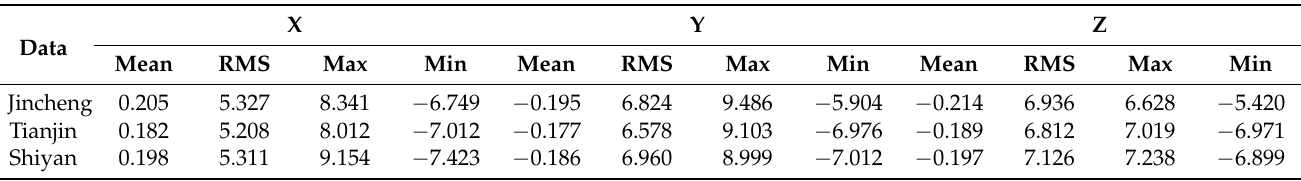
Table 7. Direct uncontrolled positioning accuracy based on calibrated alignment angles and pointing angle files. (Unit: